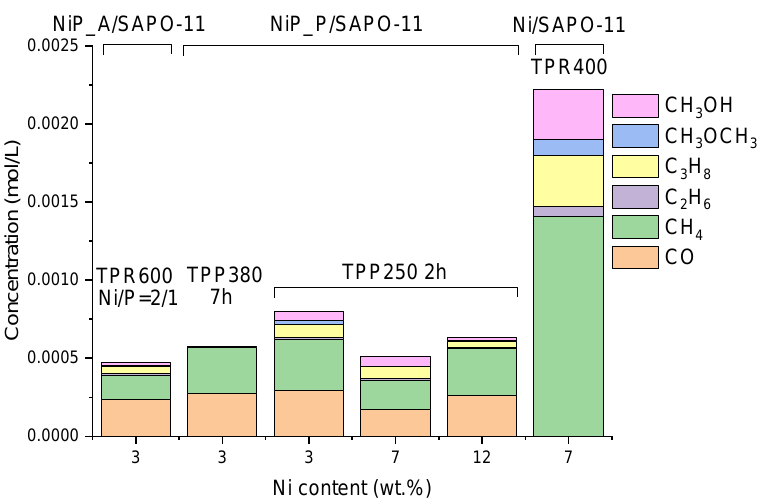
Figure 8. Distribution of gas phase products over Ni-phosphide and Ni catalysts on SAPO-11 in a continuous-flow reactor (X MP = 100%). T = 340 ◦ C, 2 MPa, LHSV = 5.3 h − 1 , 600 Ncm 3 /cm 3 . The NiP_A and NiP_P catalysts had quite similar amounts of CO and CH 4 , and the most active 7 wt.% NiP_P catalyst had the lowest concentrations (Figure 8). Interestingly, there was no C 2 H 6 , C 3 H 8 , CH 3 OCH 3 , and CH 3 OH over the NiP_P TPP380 sample.